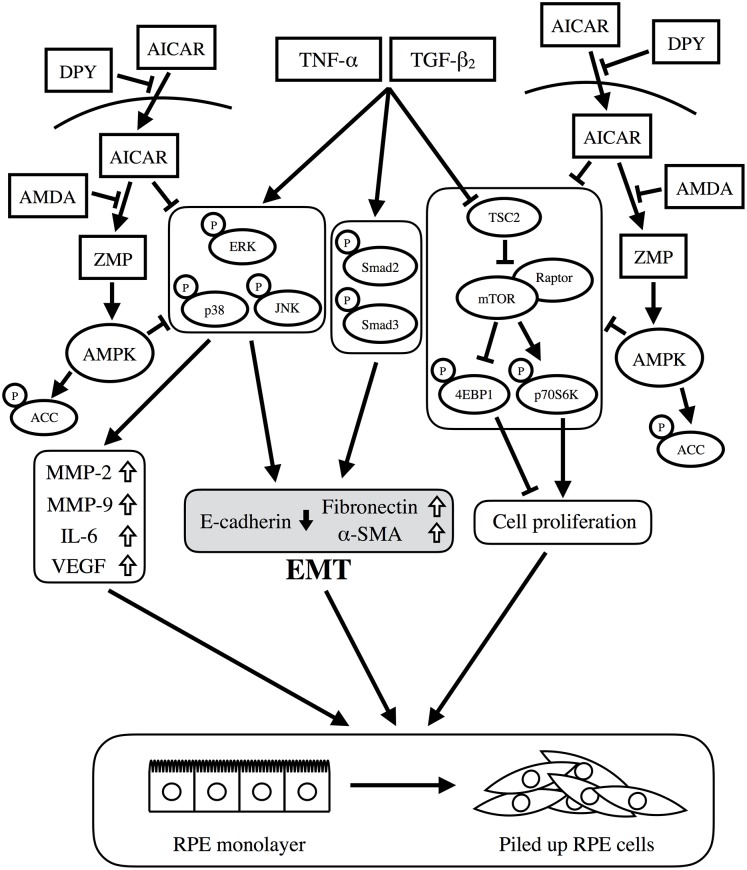
Proposed signaling pathways relevant to the effects of AICAR.TNF-α/TGF-β2 co-stimulation activates the ERK, JNK, and p38MAPK pathways, Smad2/3 pathway, and mTOR pathway. Activation of the MAPKs and the Smad pathway induces EMT (downregulation of E-cadherin with upregulation of fibronectin and α-SMA), and also upregulates MMPs and inflammatory cytokines such as IL-6 and VEGF. Activation of the mTOR pathway leads to cell proliferation. These changes disrupt the static RPE cell monolayer, leading to the formation of piled up cellular aggregates. When AICAR enters a cell, it is converted to ZMP, which mimics AMP that in turn activates AMPK and its downstream target, ACC. DPY prevents AICAR from entering the cell; AMDA inhibits AICAR’s conversion to ZMP. AICAR suppresses aggregate formation by inhibiting the ERK, JNK, p38 MAPK, and mTOR pathways, at least partially via activation of AMPK.